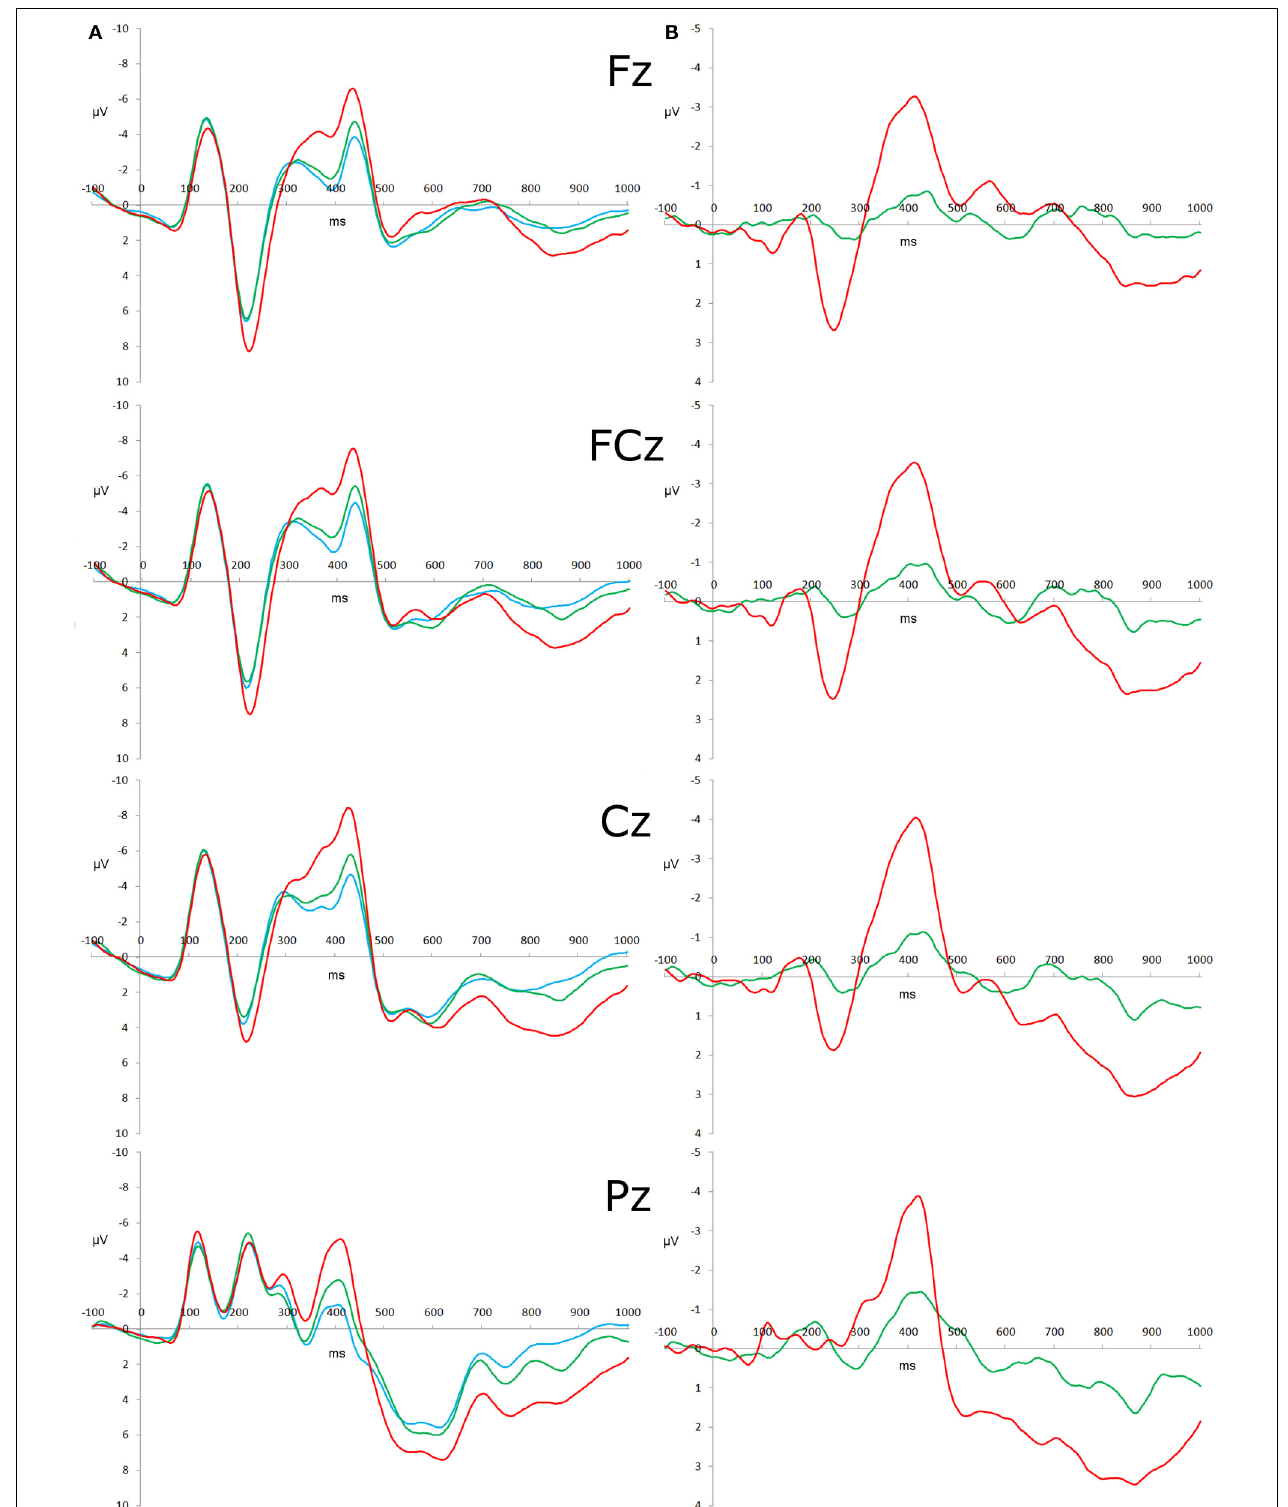
FIGURE 2 | Stimulus-locked ERP waveforms and difference waveforms. (A) Grand-averaged ERP in response to congruous (blue), incongruous (green), and reversed (red) stimuli with the amplitude ( μ V) as the y-axis and